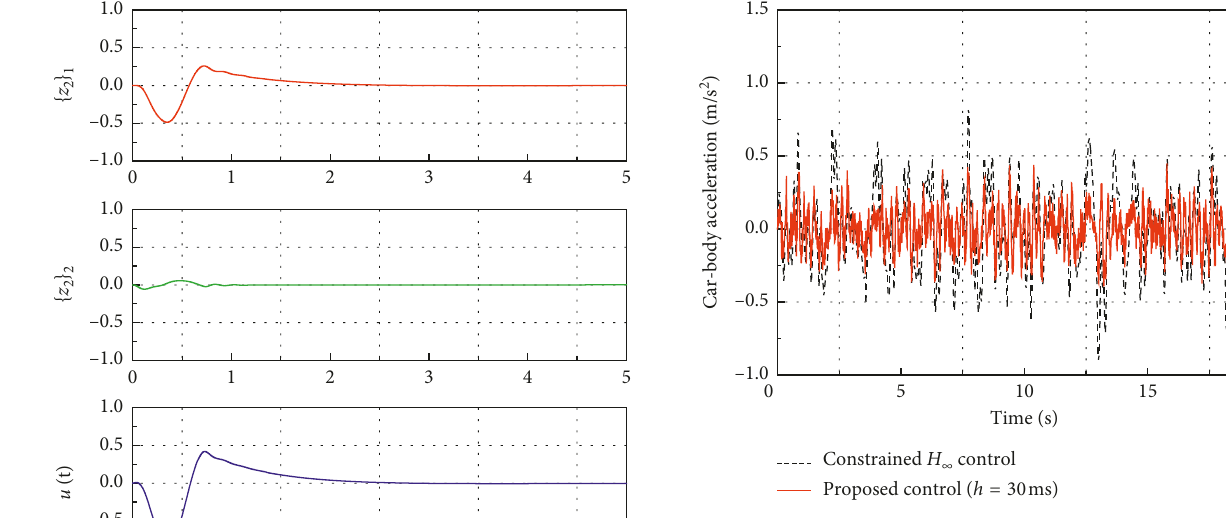
Figure 8: Car-body acceleration results under the random road disturbance.